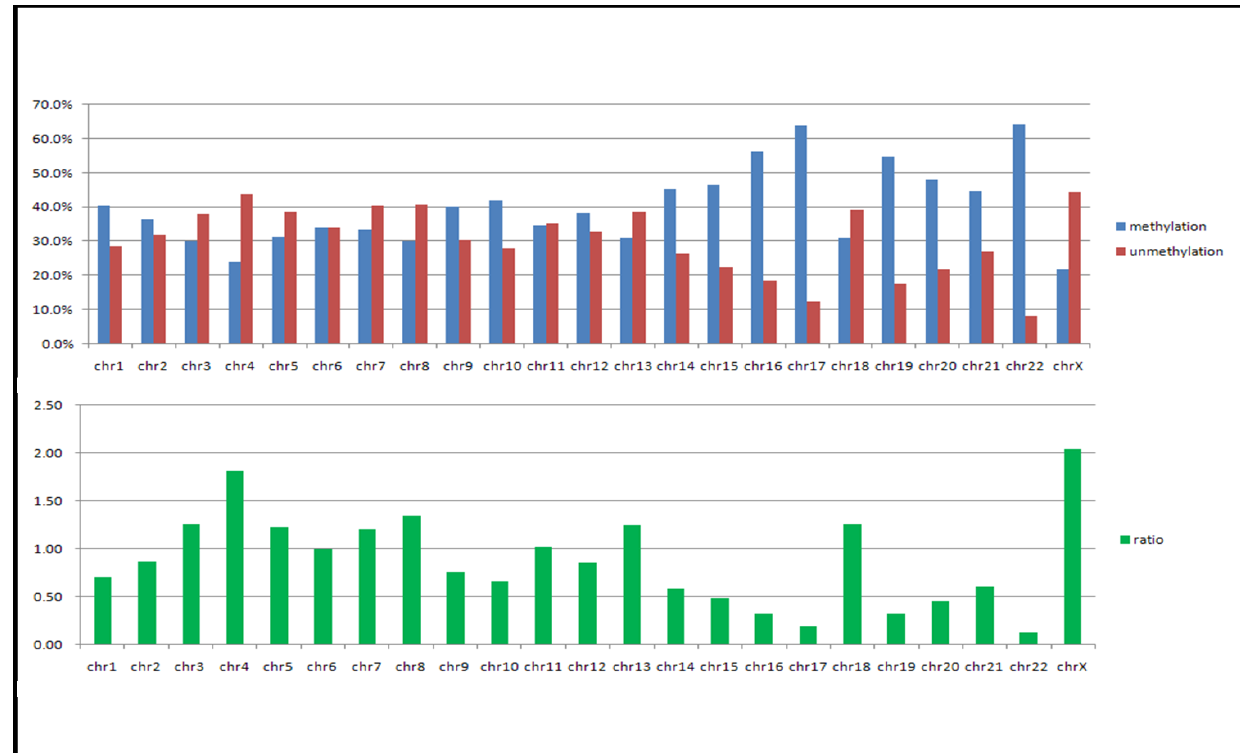
Figure 3. Degree of hypomethylation across the various chromosomes of the MCF-7 genome. The relative number of probes in the array that are hypermethylated (blue) and hypomethylated (red) are plotted for each chromosome (Upper graph). The ratio of the hypomethylated probes to the hypermethylated probes are shown in the lower graph. The X chromosome and chromosome 4 are the most hypomethylated chromosomes, whereas chromosomes 7 and 22 are the most hypermethylated